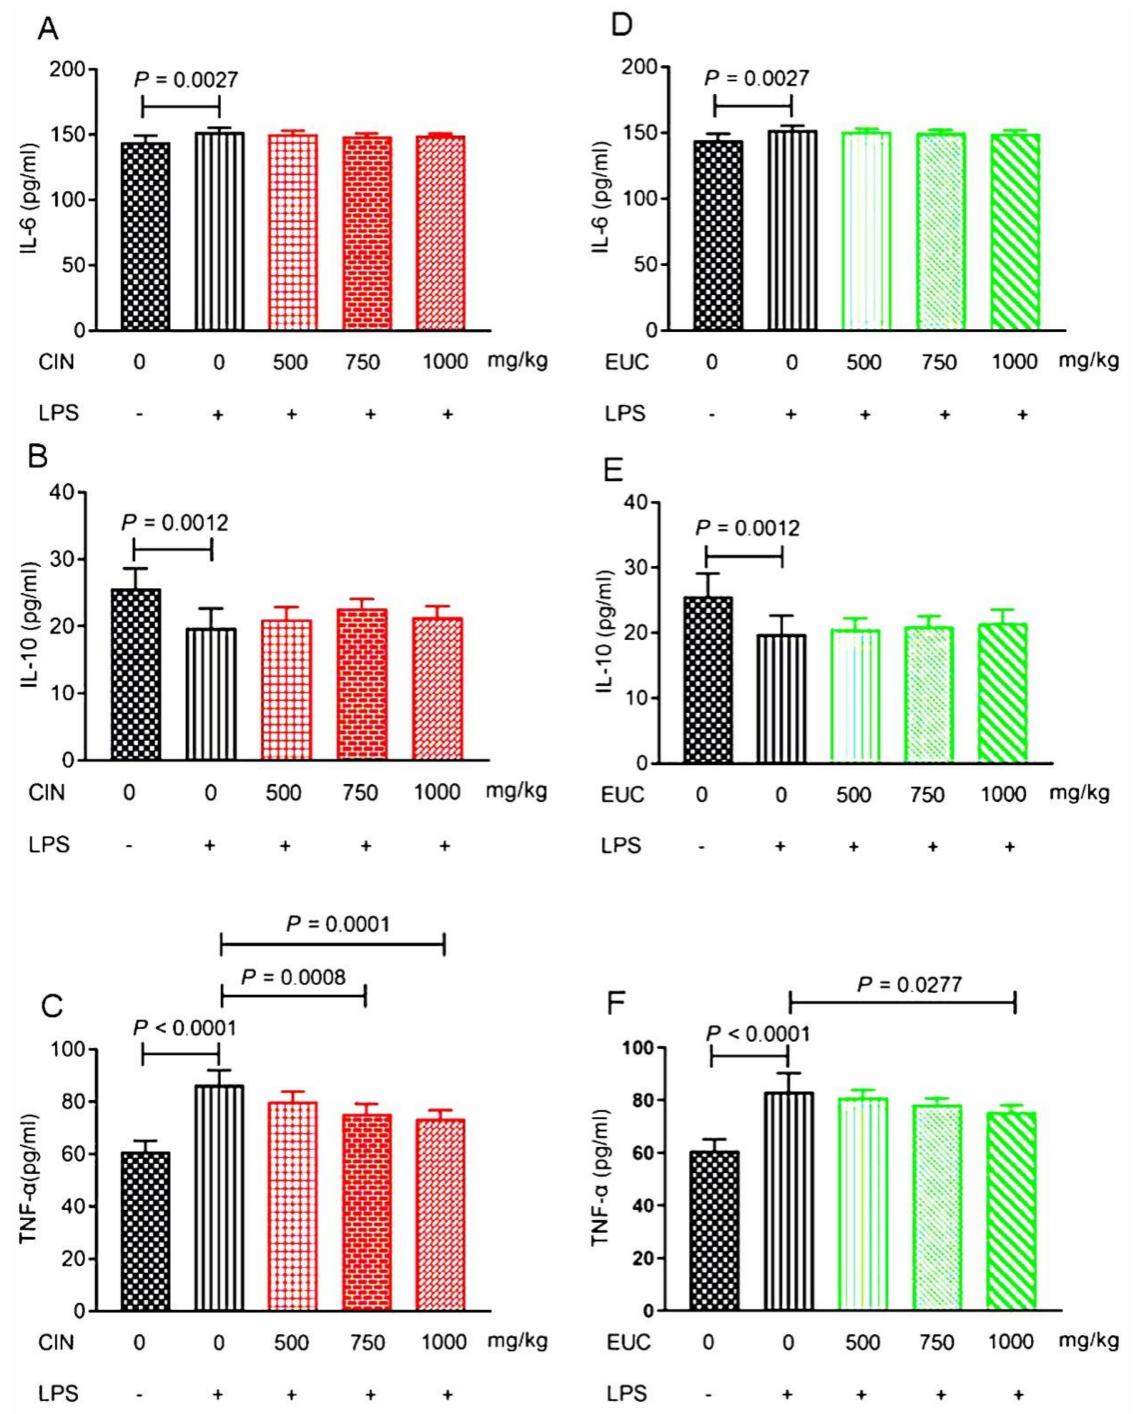
Figure 2. Effect of EOs on inflammatory factors of serum in mice induced by LPS. Effects of cinnamon oil on LPS-induced secretion of IL-6 ( A ), IL-10 ( B ), and TNF- α ( C ) in mice. Effects of eucalyptus oil on LPS-induced secretion of IL-6 ( D ), IL-10 ( E ), and TNF- α ( F ) in mice. Data are presented as mean ± standard error of measurement (mean ± SEM) ( n = 6). The concentration of LPS induced in mice was 10 mg/kg. The concentration of cinnamon oil and eucalyptus oil were 500 mg/kg, 750 mg/kg, and 1000 mg/kg, respectively. CIN, cinnamon oil; EUC, eucalyptus